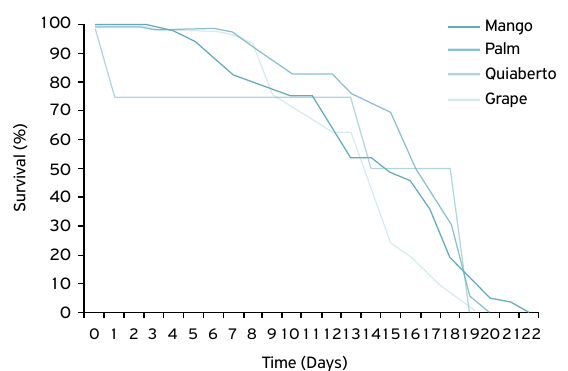
Figure 5. Survival of adults C. capitata from larvae created in fruit of mango, palm, quiabento and grape. Vitória da Conquista, BA,